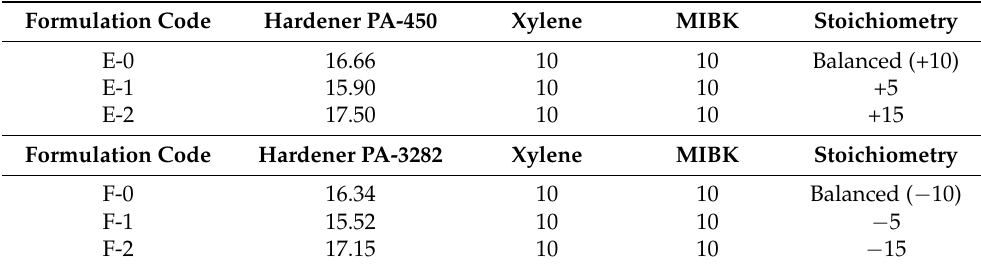
Table 1. Formulating ingredients of prepared